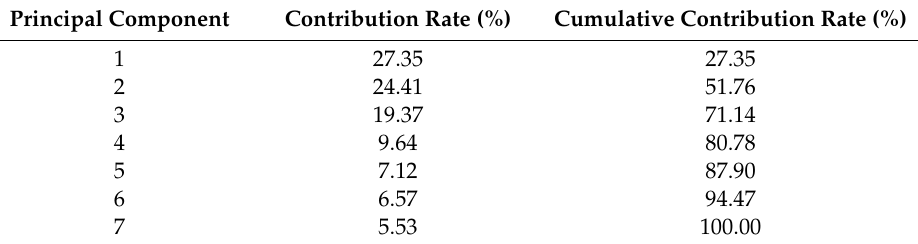
Table 2. Contribution of each principal